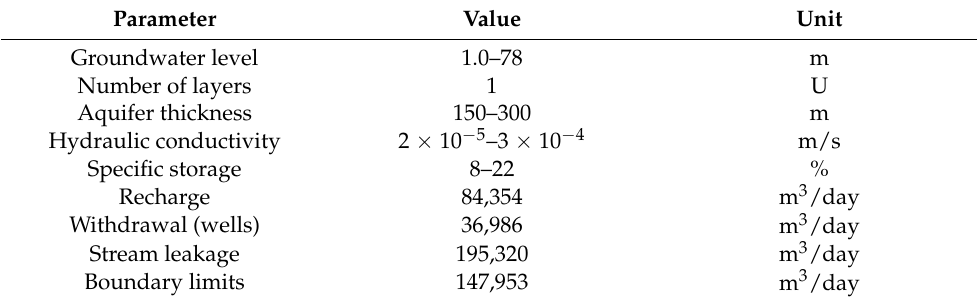
Table 2. The aquifer parameters used for model setup and calibration.